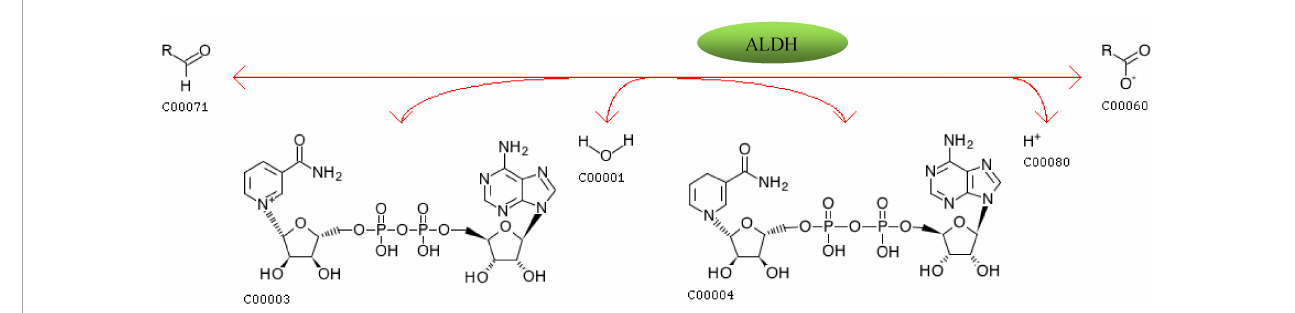
FIGURE13 The oxidation equation of aldehydes catalyzed by aldehyde dehydrogenase.